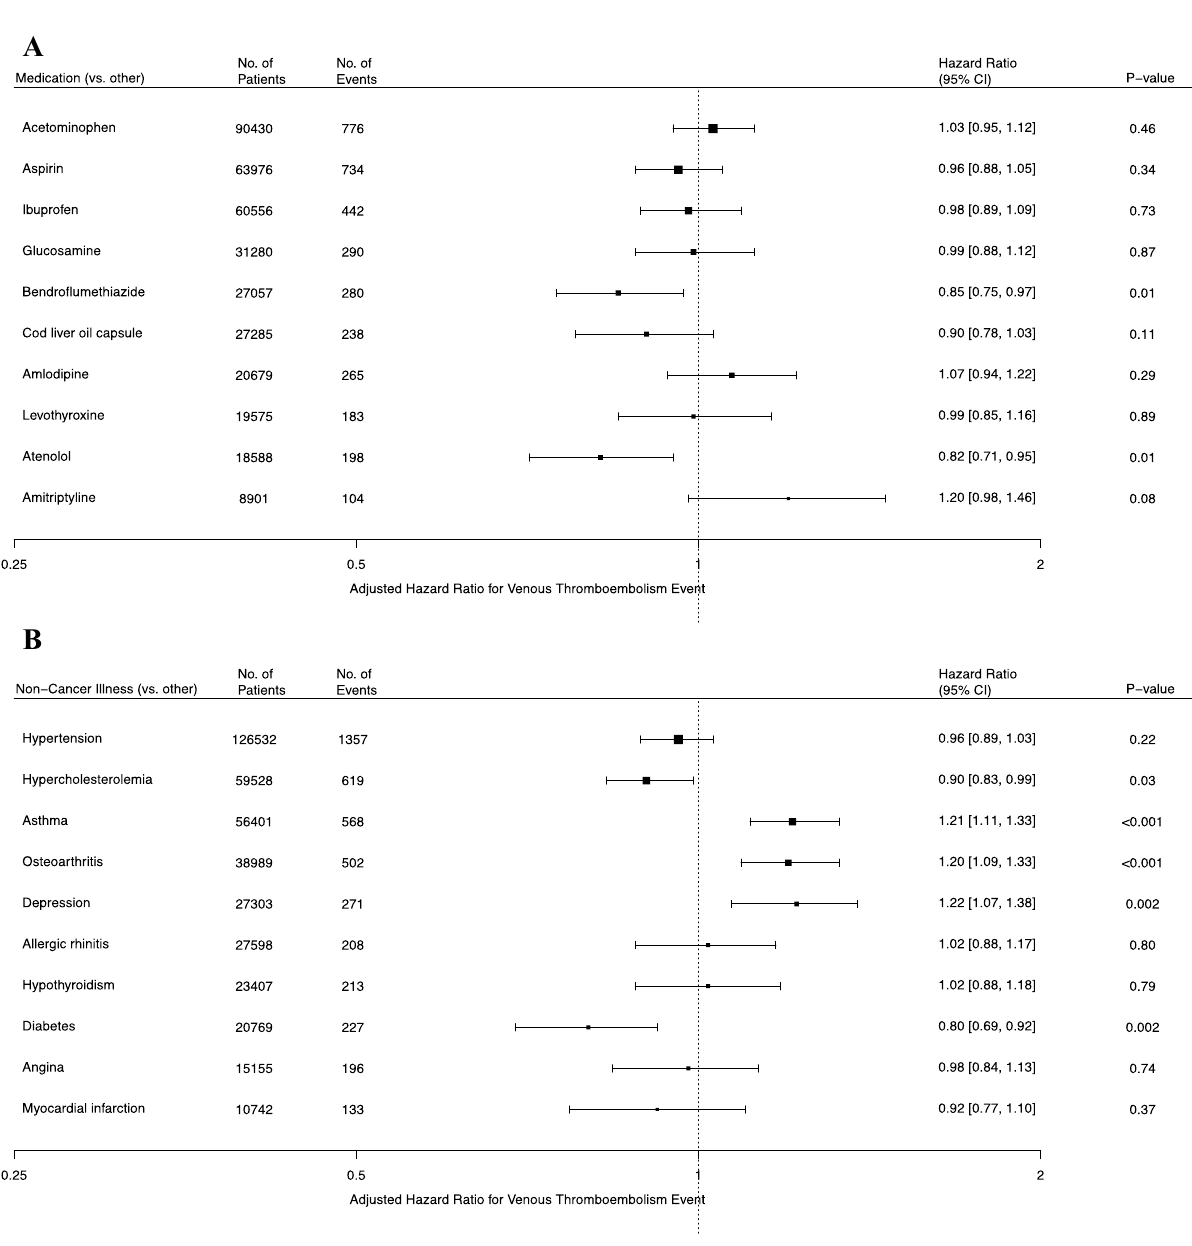
Figure 2. Adjusted hazard ratios for primary venous thromboembolism for common medications and non- cancer illnesses. Shown are the adjusted hazard ratios for primary venous thromboembolic events for two factors of interest: common medications ( A ) and non-cancer illnesses ( B ). All estimates were adjusted for all nine established risk factors and the first four principal components of ancestry. The I bars represent 95% confidence